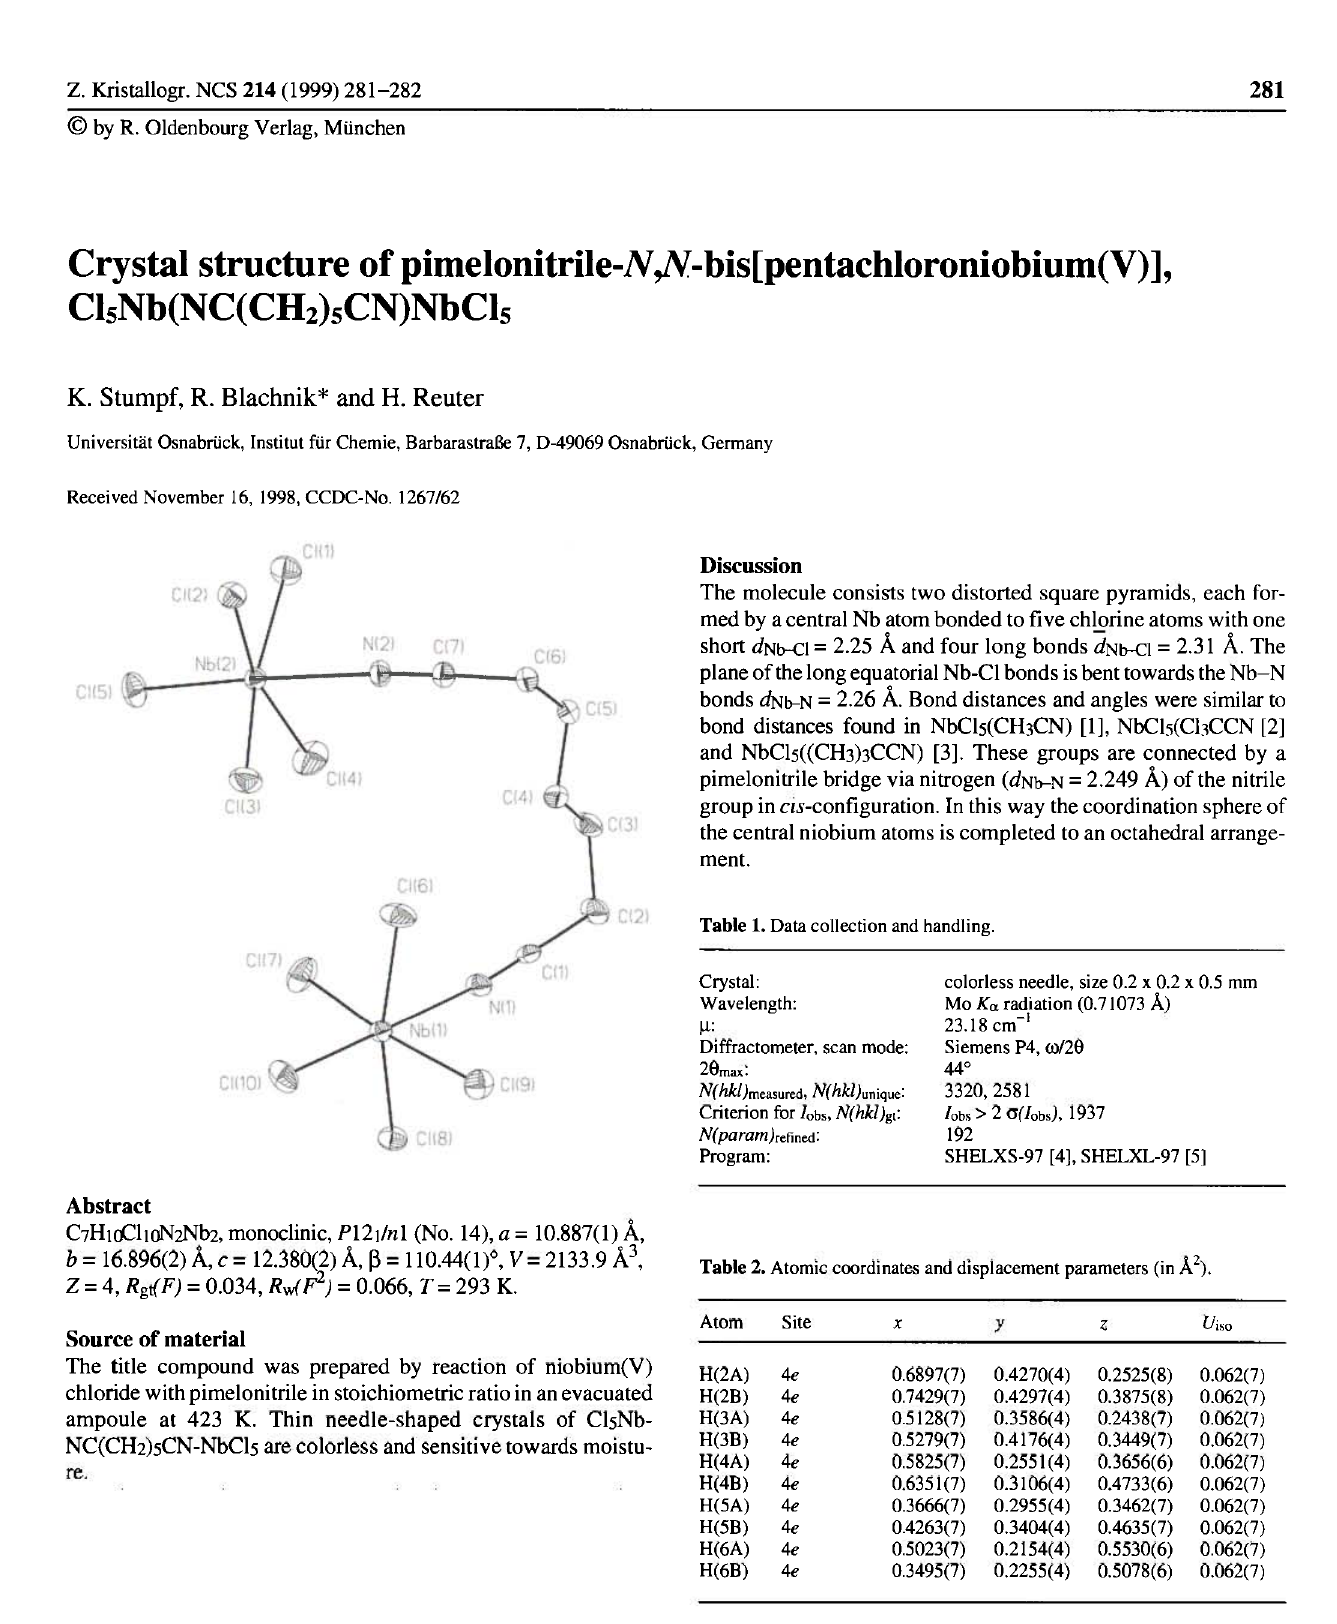
Table 2, Atomic coordinates and displacement parameters (in Ä 2